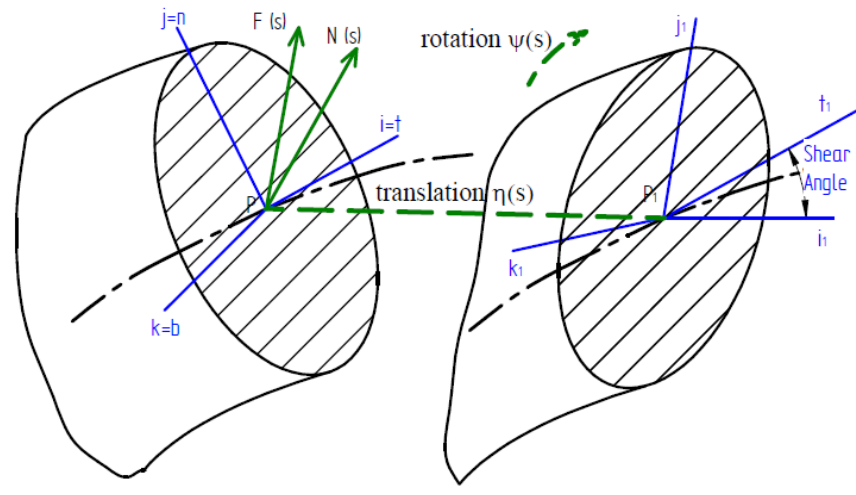
Figure 5. Schematic of the oscillations of the spring section. Due to the shear produced by the shear forces, the i-axis is not transformed into the i-axis 1 by rotation and translation. Consequently, the tangent vector to a point on the midline of the part will no longer coincide with the first axis of the trihedron as it did in the initial equilibrium state but will form an angle 𝛽⃗ , called the shear angle, proportional to the shear stress. If we do not consider the deformation due to the shear stress, the shear angle is canceled, so that the tangent to the midline of the part will be perpendicular to the section, or what is the same, will coincide with the first axis of the trihedron. → ψ with respect to s is given to first order by Equation (9a,b). The derivative of